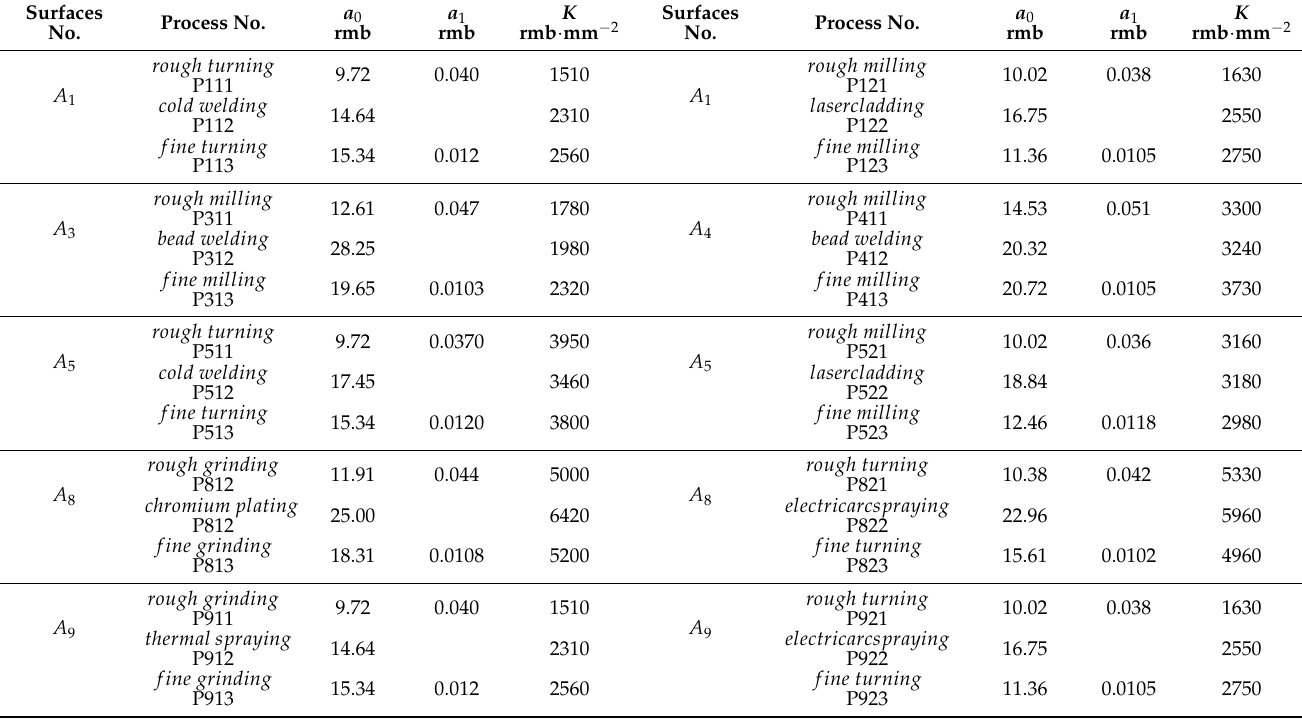
Table 5. The parameter of each feasible process plans of a used